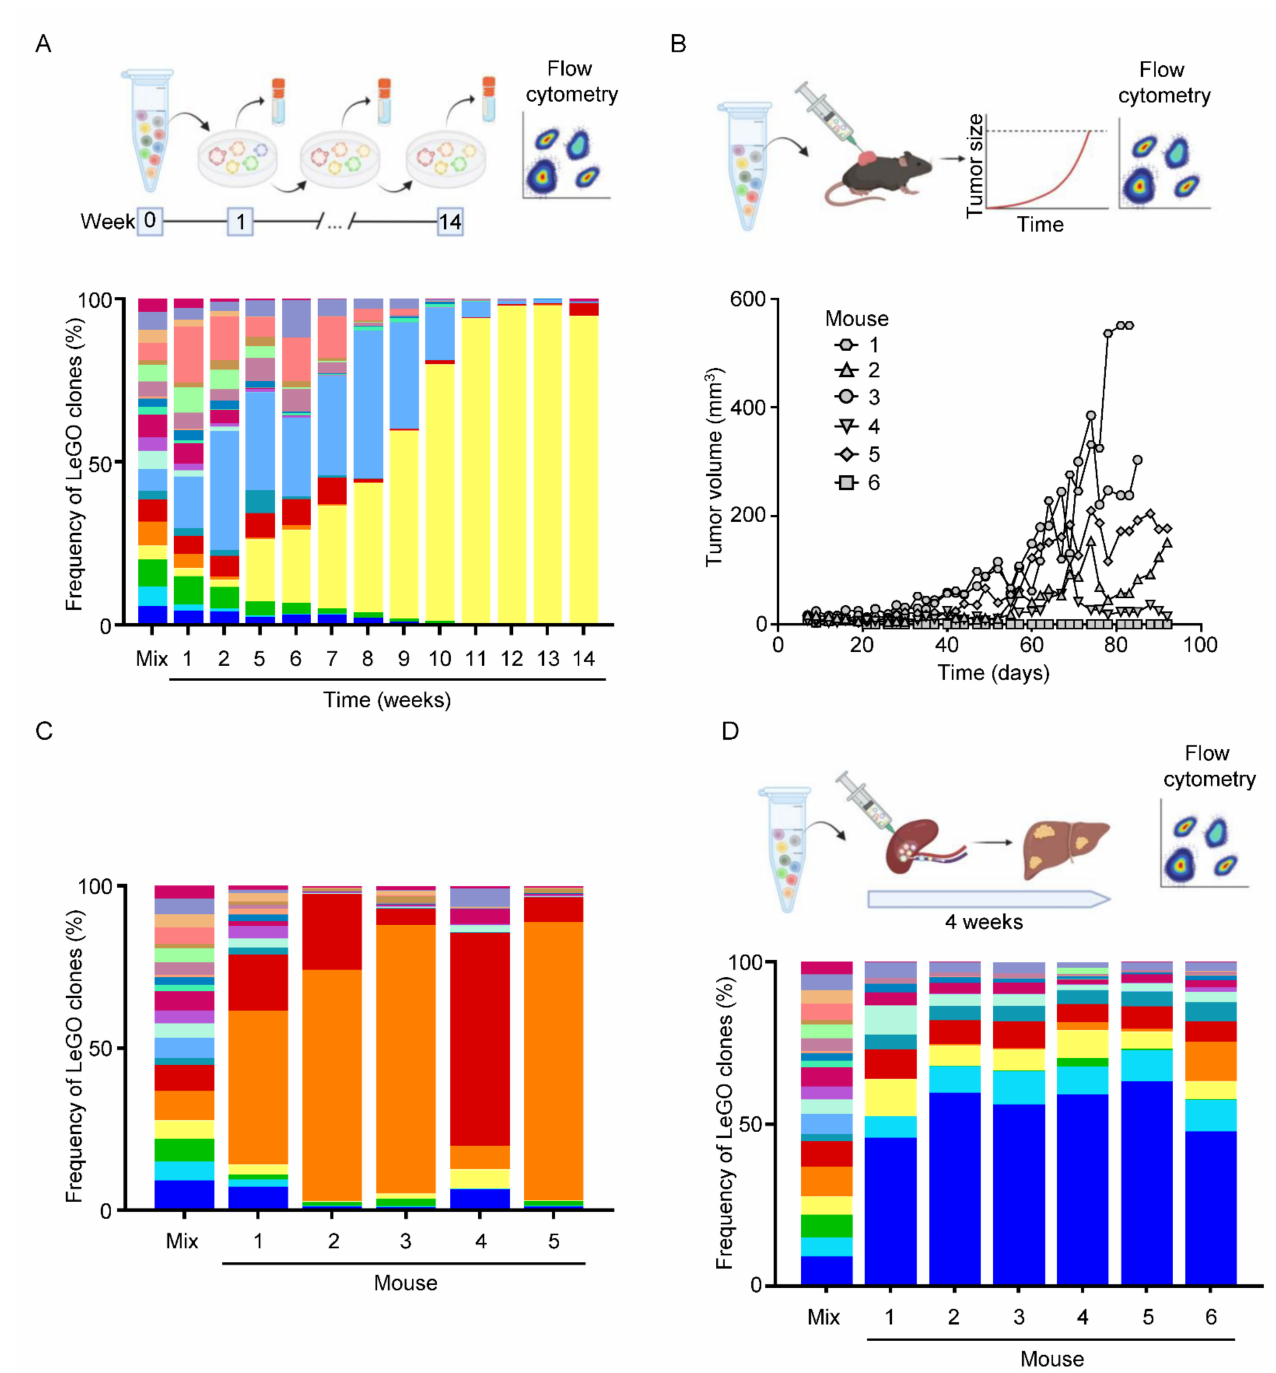
Figure 6. Clonal analysis for niche dependencies. ( A ) Schematic representation of the workflow for the study of clonal selection in vitro and the frequency of clones at indicated time points of the in vitro assay analyzed by flow cytometry. ( B ) Schematic representation of the workflow to study clonal selection in sub-cutaneous tumors and tumor growth of the sub-cutaneous tumors. ( C ) Frequency of the barcoded clones in sub-cutaneous tumors. ( D ) Schematic representation of the workflow for the study of clonal selection in liver metastases and frequency of barcoded clones in liver metastases detected by flow